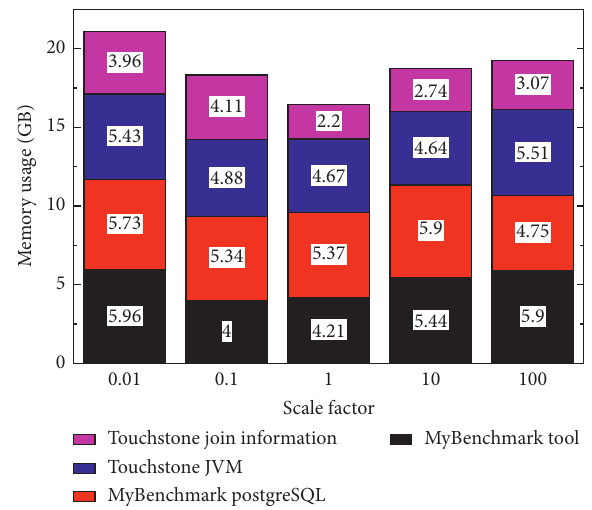
Figure 4: Comparison of memory consumption.